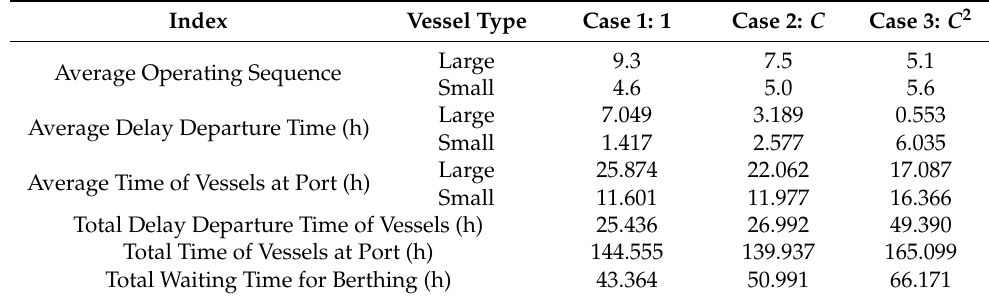
Table 3. Results comparisons of objective function 1 and objective function